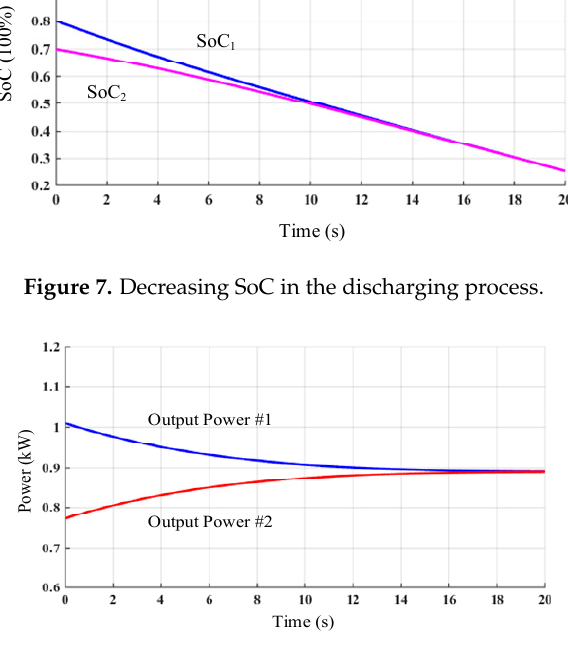
Figure 8. Waveforms of discharging power.